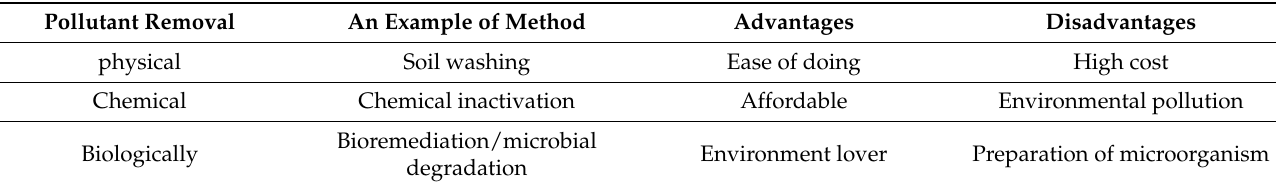
Table 2. General comparison of methods for removing PAHs